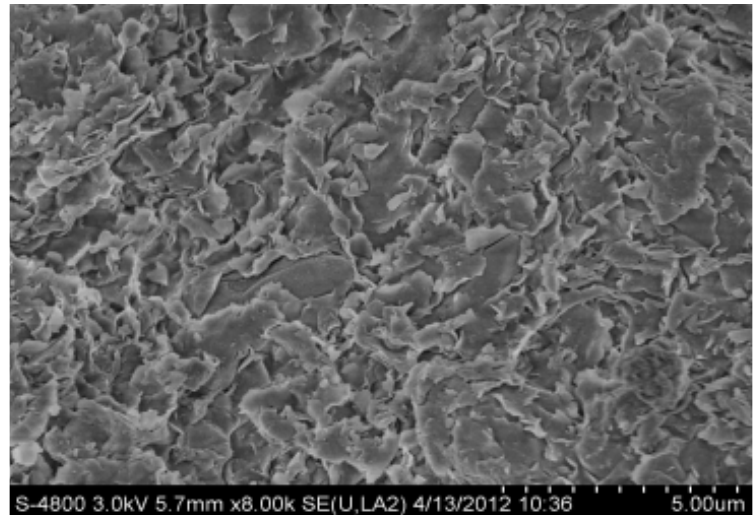
Figure 4. SEM of bentonite soaked in water.